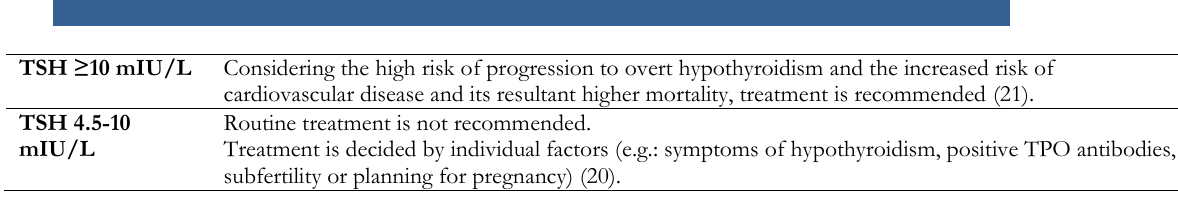
Table 2.7. Levothyroxine replacement in subclinical